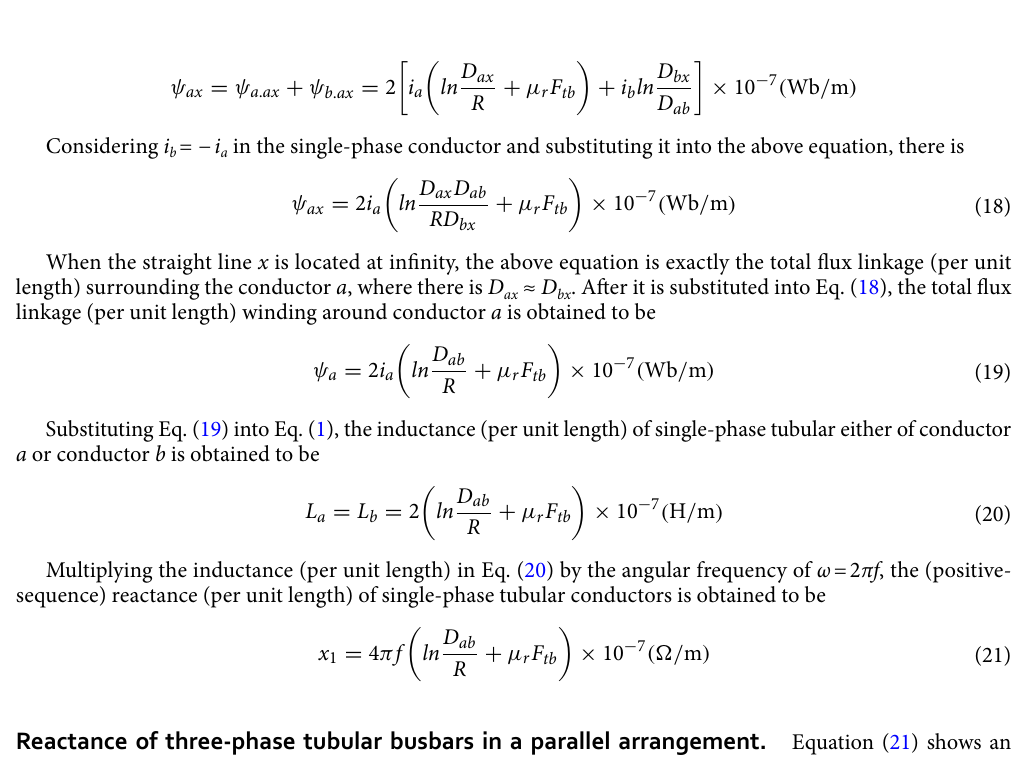
Figure 2. The distribution of magnetic fields of a single-phase